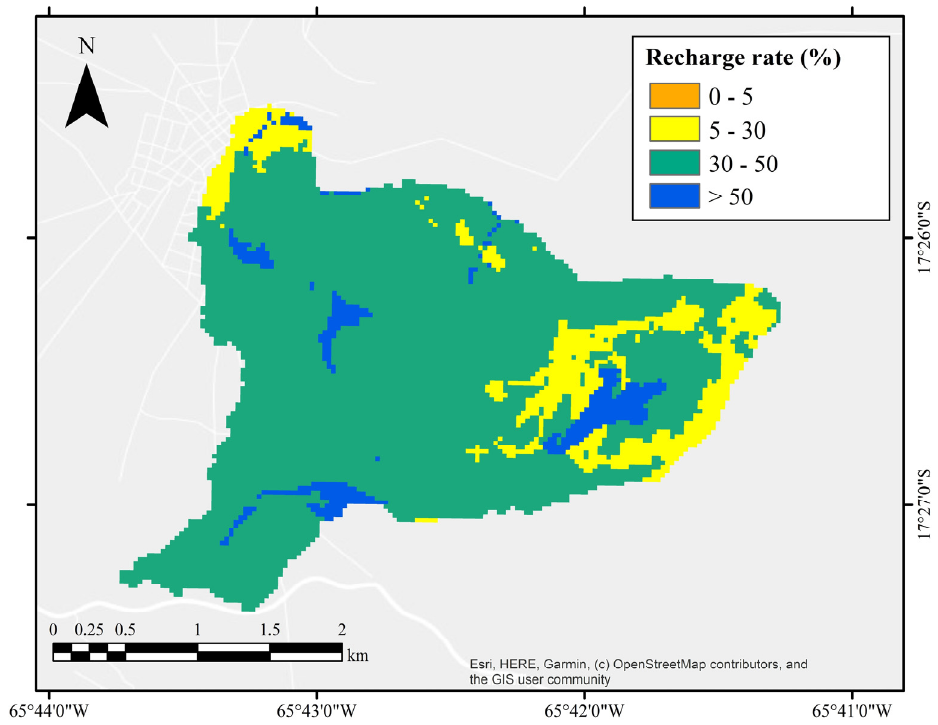
Figure 11. Long-term (5 years) spatially distributed groundwater recharge rate (in percentage) of the Virvini micro-basin, according to the WetSpass-M model.